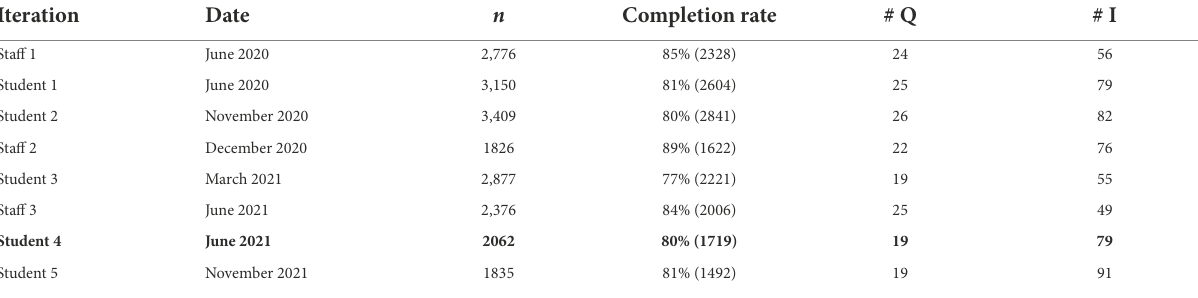
TABLE 1 An overview of the different iterations of wellbeing assessment conducted at Delft University of Technology.